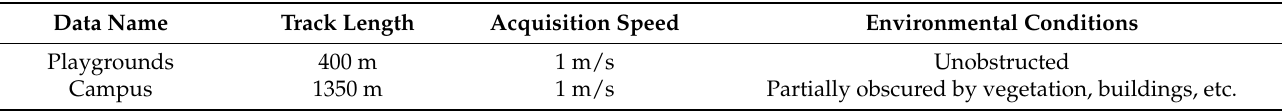
Table 2. Experimental dataset